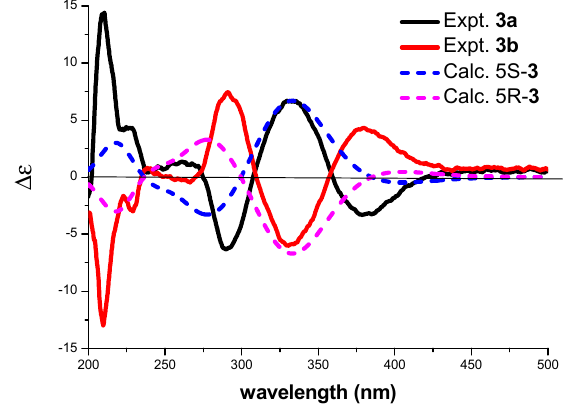
Figure 6. The experimental ECD spectra of 3a and 3b and calculated ECD spectra for (5 S )- 3 and (5 R )- 3 (UV correction = − 20 nm, band width σ = 0.3 eV).